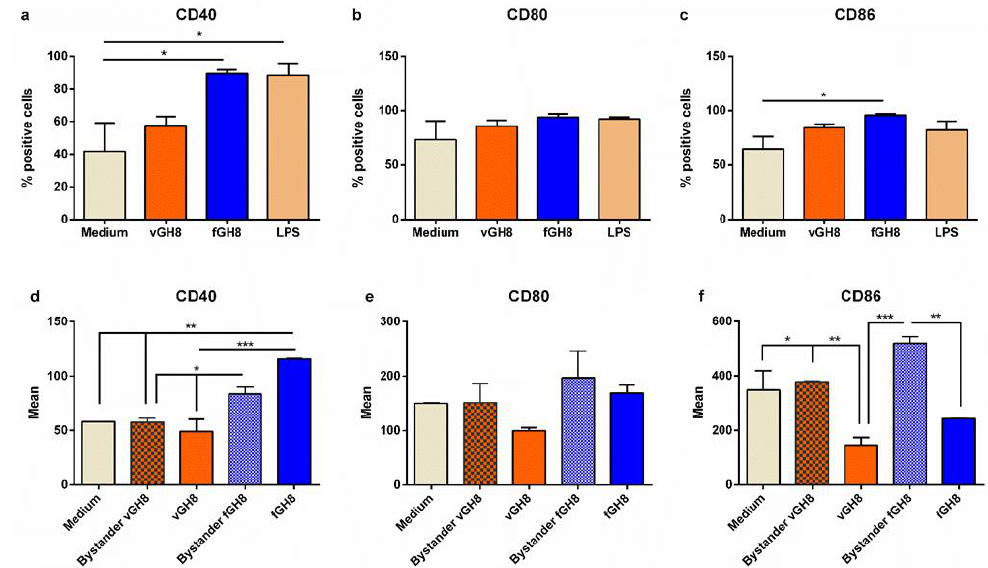
Figure 2. Evaluation of maturation of L . infantum -infected BMDCs and fixed parasite-harboring BMDCs. Populations expressing: ( a ) CD40, ( b ) CD80 and ( c ) CD86 co-stimulatory molecules were detected by flow cytometry. ( d – f ) The surface co-stimulatory molecules were further analyzed in bystander and L . infantum -infected BMDCs and fixed parasite-harboring BMDCs expressed as Mean (mean fluorescence). The mean ± SD of three independent experiments is shown (*: p < 0.05, ** p < 0.01, ***: p < 0.001). Overall, Leishmania may directly interact with BMDCs to induce weak maturation in a minority of cells also affecting the bystander populations by inhibiting their maturation.